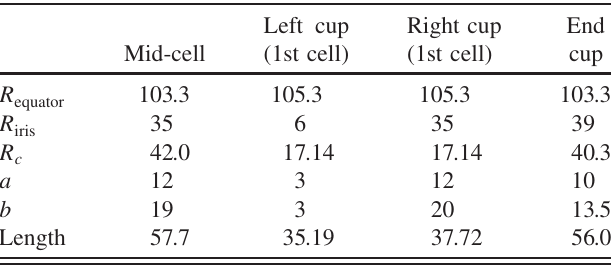
FIG. 3. Geometry of the 3.5-cell cavity. TABLE I. Geometry parameters of the 3.5-cell cavity (unit: mm).